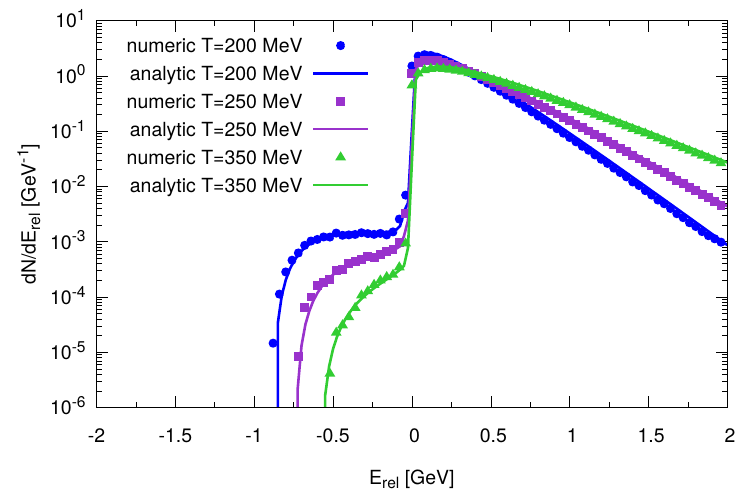
Figure 4. Pair-energy distribution for different temperatures. Due to stronger screening effects higher temperatures lead to a smaller yield of bound states.